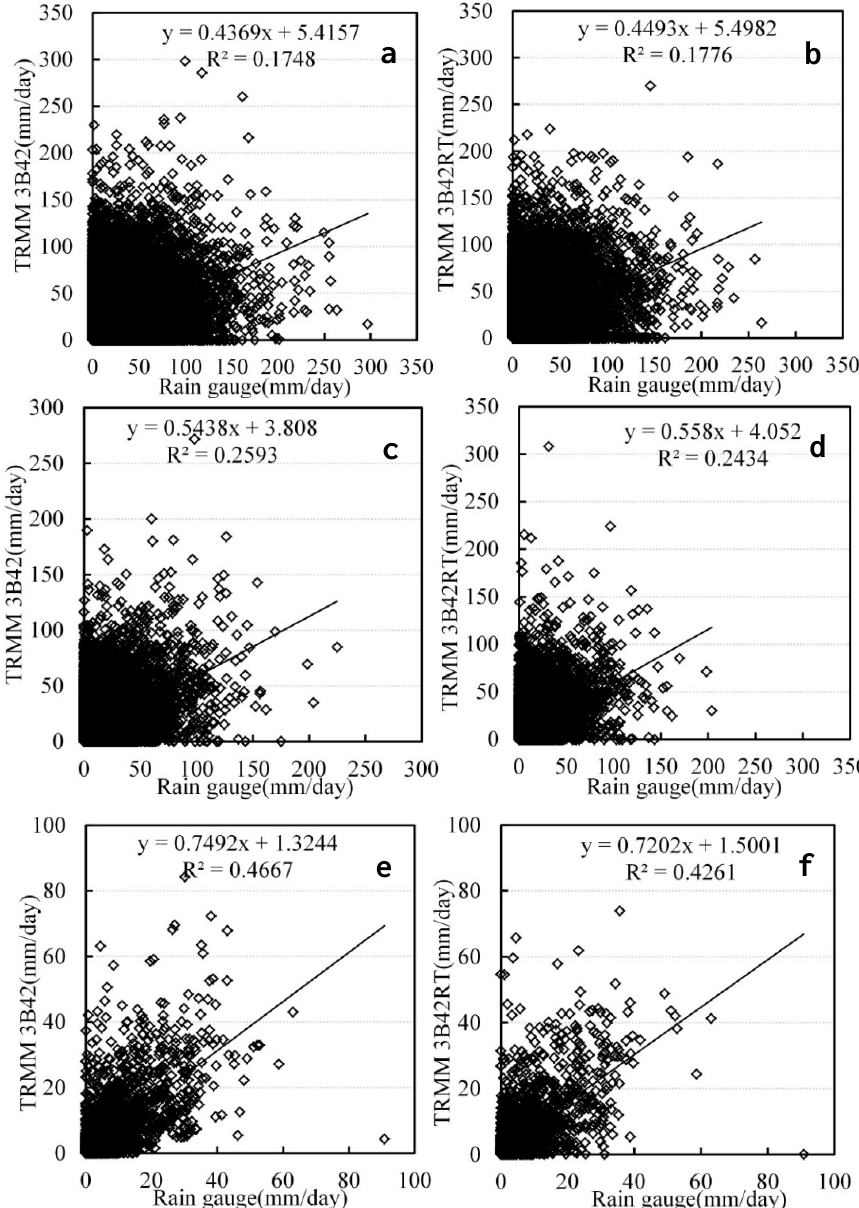
Figure 3. Scatter plots of TRMM 3B42 or 3B42RT versus rain-gauge data for the period from 1998 to 2007, with ( a , b ) for 0.25° × 0.25° pixel scale; ( c , d ) for 1° × 1° pixel scale; ( e , f ) for basin scale; ( a , c , e ) for TRMM 3B42; ( b , d , f ) for TRMM 3B42RT.